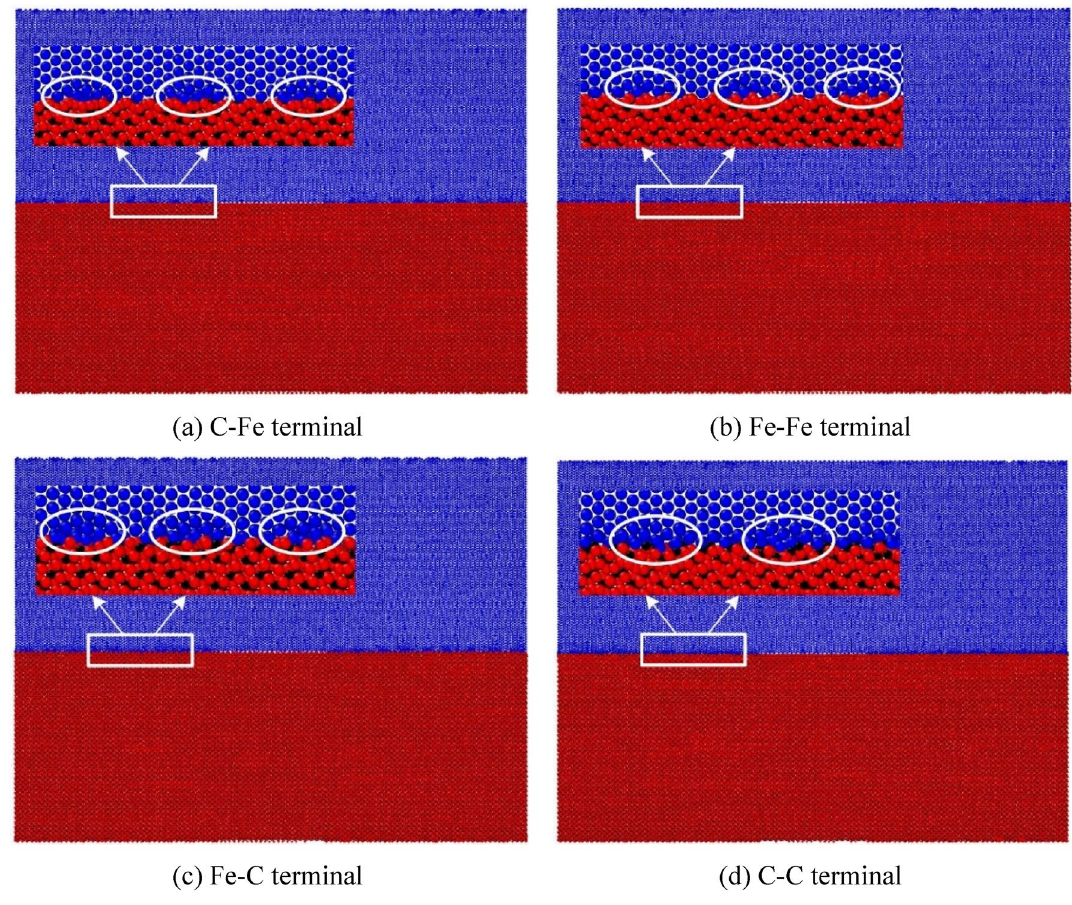
Figure 7. Sample morphology after